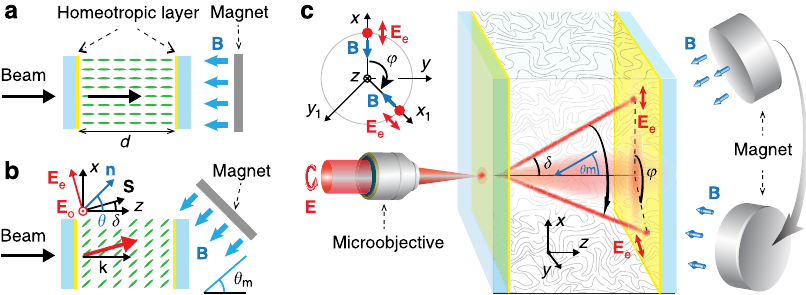
Figure 1 | Basic configuration of the magnetic routing of self-induced waveguides in nematic liquid crystal. A circularly polarized laser beam propagates along the z axis, normally to the glass slide-NLC interface and focuses into the NLC bulk. The homeotropic layers (shaded in yellow) on the inner surfaces of input and output glass slides ensure an initial alignment of the NLC molecular director predominantly along z . Such homeotropic orientation can be ( a ) strengthened or ( b ) altered by applying an external magnetic field B at a polar angle y m with respect to z, reorienting the molecular director n at a new polar angle y . For y m a 0 an extraordinary light beam with electric vector E e can self-trap into a soliton while propagating with walk-off d between its Poynting vector S and its wavevector k 77 z . ( c ) 3D angular steering of an extraordinary polarized soliton by varying the orientation of the magnetic field. A rotation of the magnetic field at the azimuthal angle j modifies the soliton direction by the same angle.